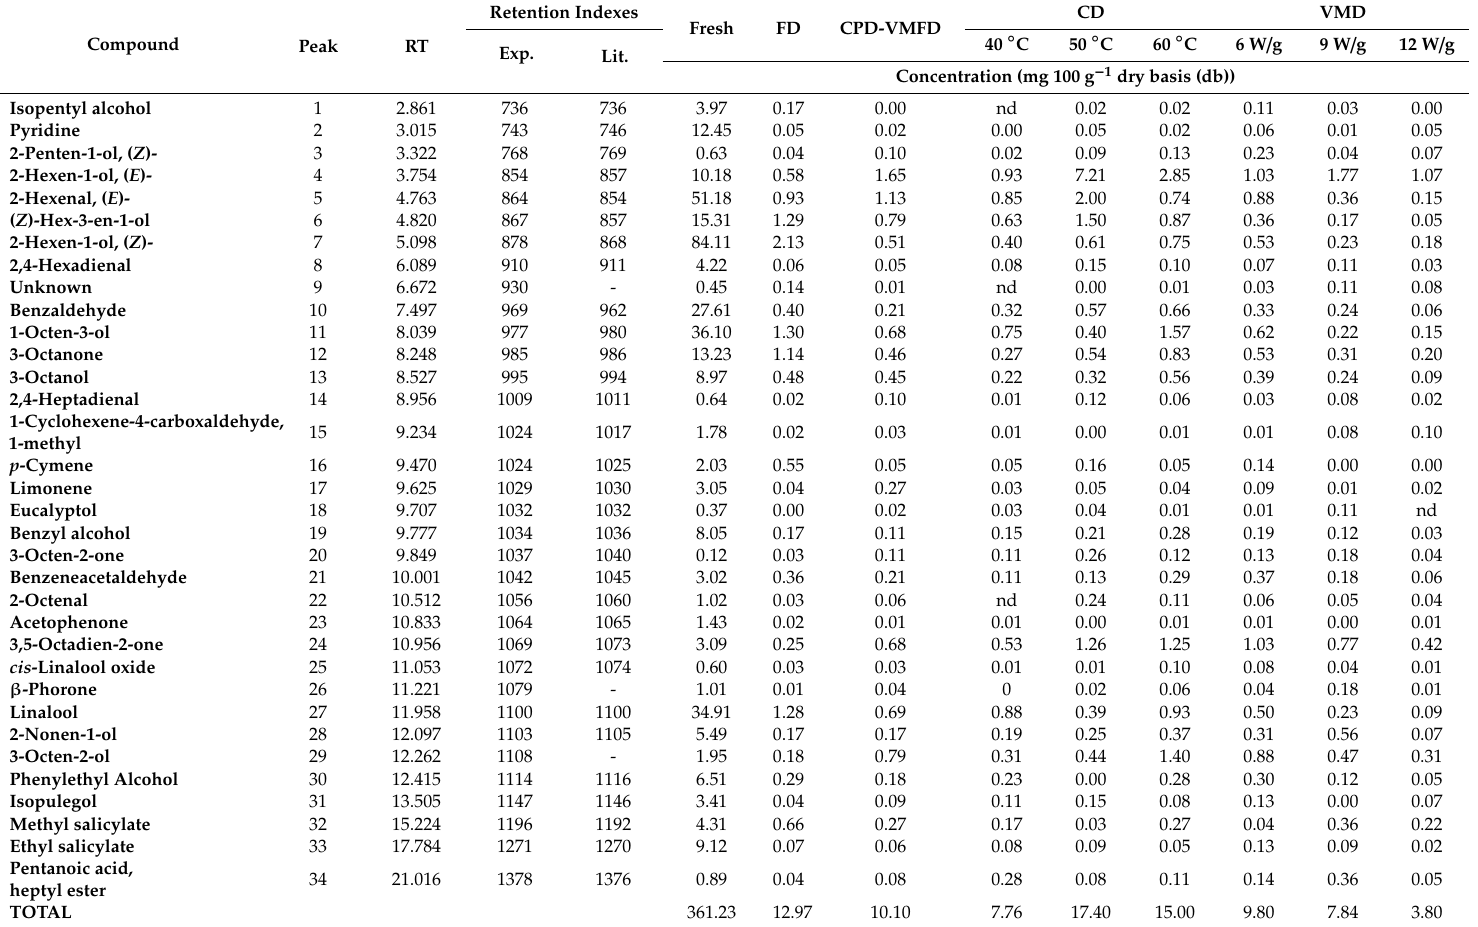
Table 2. Concentration of volatile compounds influenced by drying